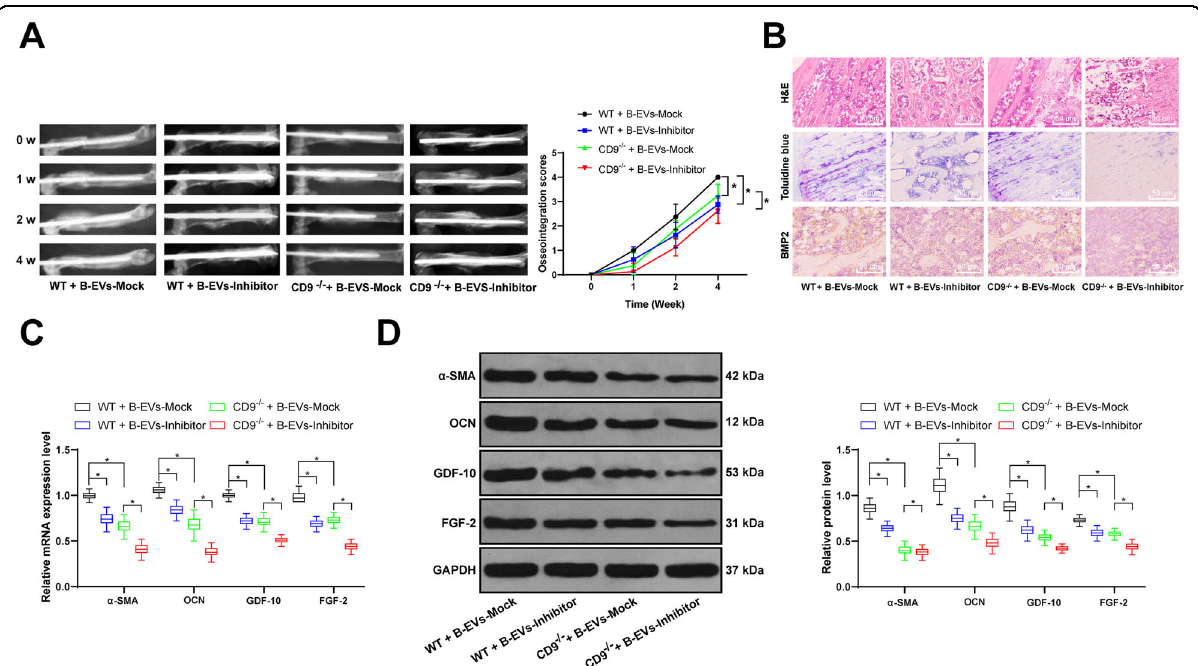
Fig. 3 Silencing miR-335 partially counteracts the promoting effect of B-EV on fracture recovery. The EVs were extracted from BMSCs transfected with miR-335 inhibitor or its negative control Mock for 48 h, and treated on WT and CD9 − / − fracture mice on the 1st and 8th days after the fracture. A Representative radiologic images of WT and CD9 − / − fracture mice at 0, 1, 2, and 4 weeks after EV treatment. B HE staining, Toluidine blue staining, immunochemistry of BMP2 were performed to observe the femoral fracture healing of WT and CD9 − / − fracture mice treated with EVs- inhibitor. C RT-qPCR and D western blot analysis were performed to determine mRNA and protein levels of α -SMA, OCN, GDF-10, and FGF-2 in femurs of mice 2 weeks after fracture. Data are expressed as mean ± standard deviation. Two-way ANOVA and Tukey ’ s multiple comparisons test were used to determine statistical signi fi cance. * p < 0.05. n = 8 in each